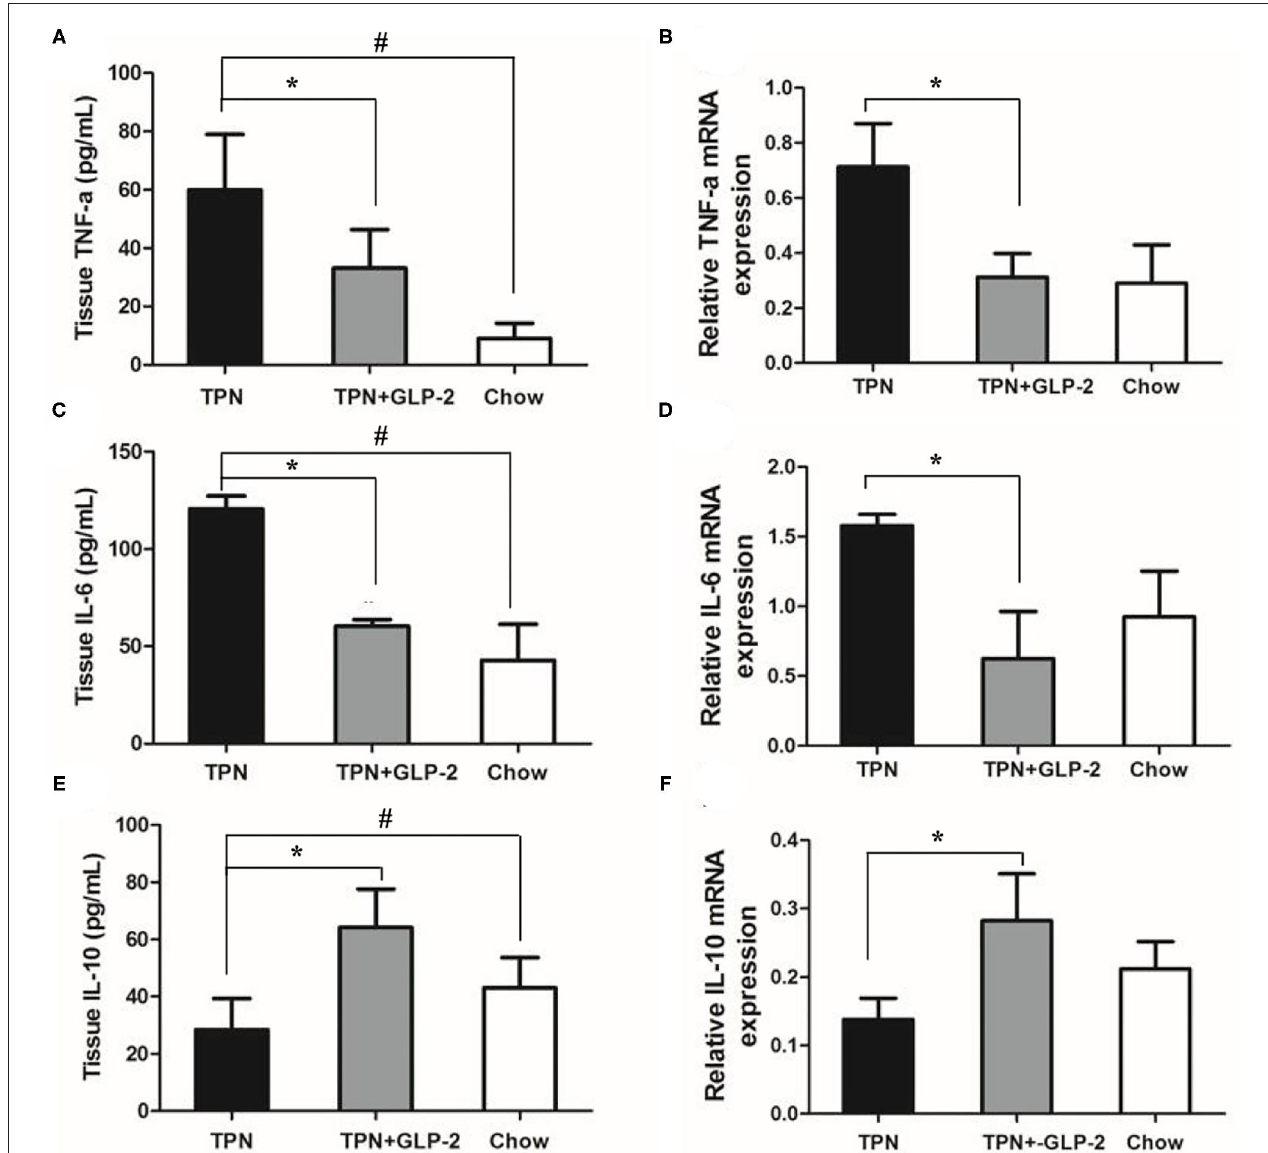
FIGURE 5 | The intestinal inflammatory cytokine levels. (A,B) Expression of TNF- α protein and mRNA. (C,D) Expression of IL-6 protein and mRNA. (E,F) Expression of IL-10 protein and mRNA. Where *indicates p < 0.05 for TNP vs. TPN + GLP-2 and Chow, and # indicates p < 0.05 for TNP vs. Chow.